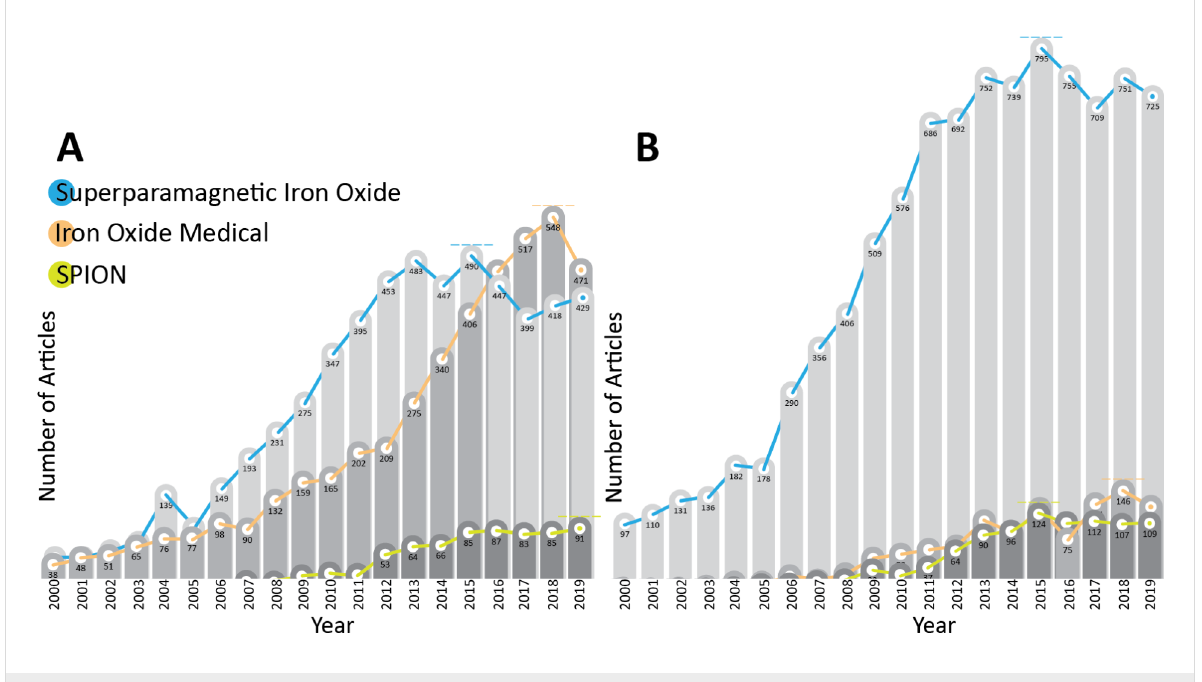
Figure 2: Number of publications per year on the topic of superparamagnetic iron oxide with biological and medical applications between 2000 and 2019. (A) Values obtained using the Web of Science database (total counts per search – blue: 9575, orange: 1099, green: 966). (B) Values obtained using Medline (PubMed) trendline count (total counts per search – blue: 5610, orange: 4436, green: